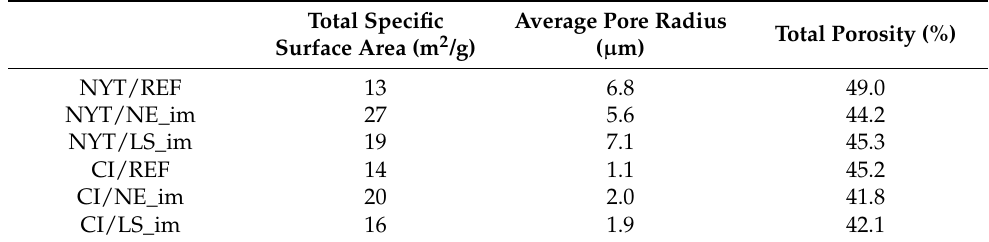
Table 5. Porosity data of treated and untreated tuff specimens measured by mercury intrusion porosimetry